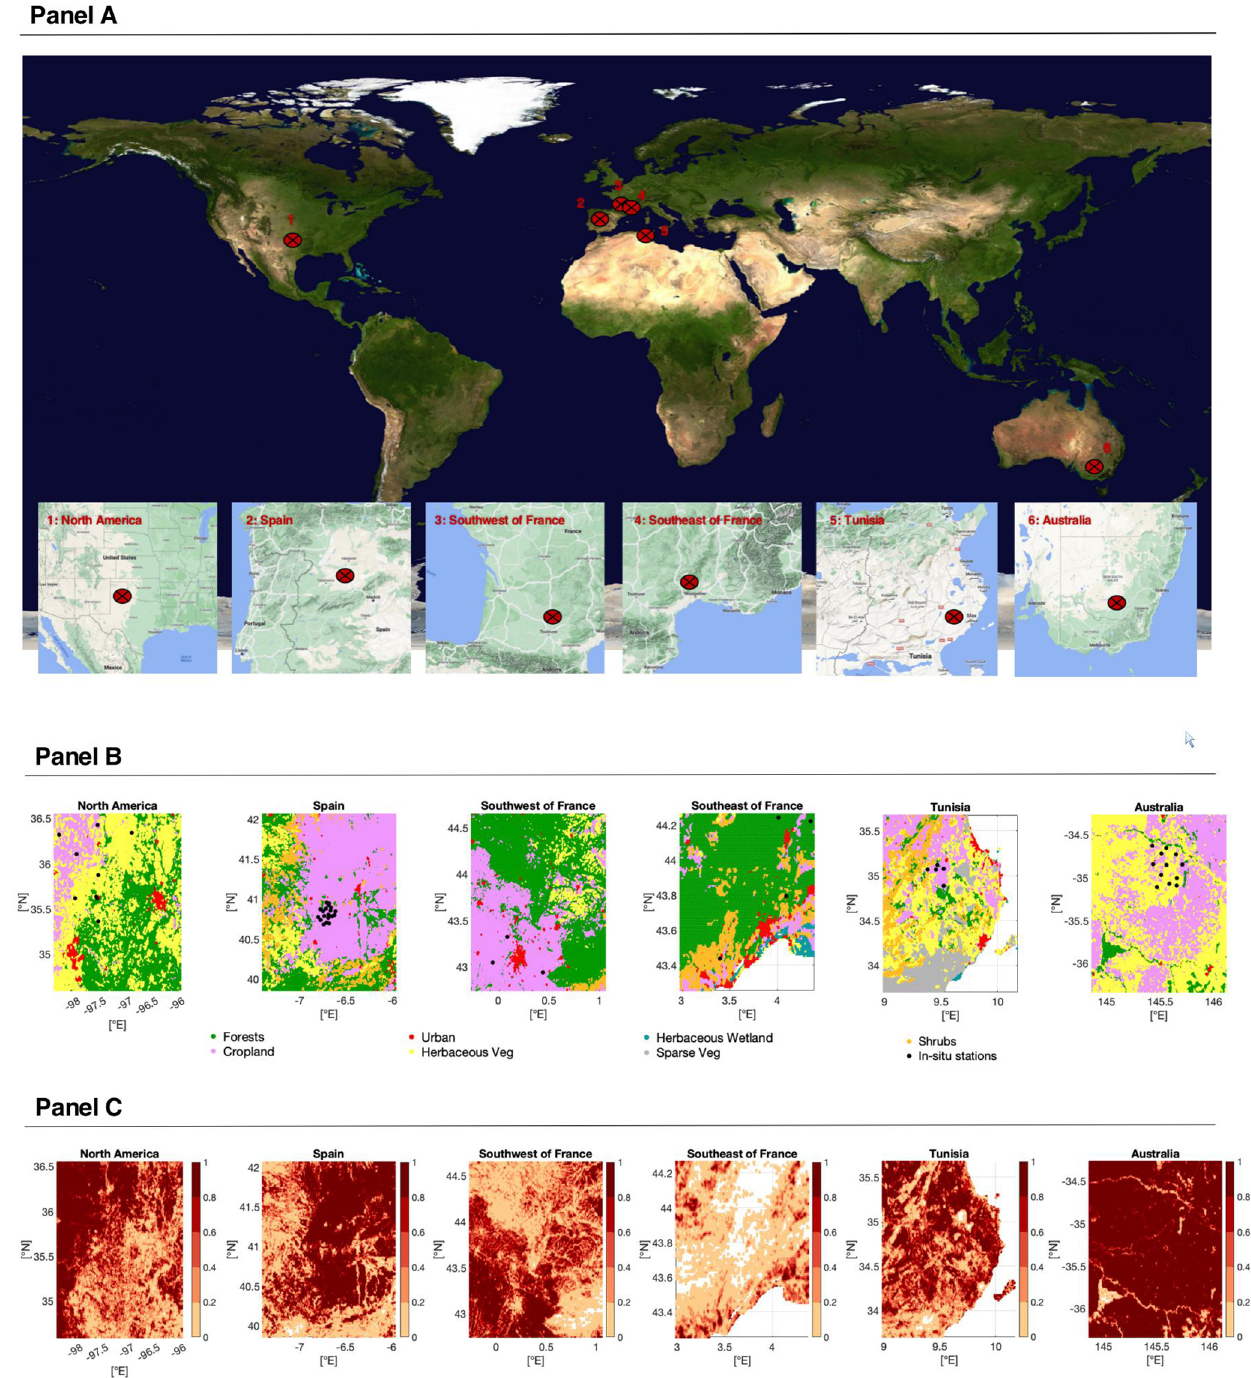
Figure 1. (a) Global locations of the six regions of study (© Google Maps 2022). (b) Copernicus land cover maps of the six regions of study aggregated at 1km spatial resolution. Only the dominant land cover type within a 1km 2 pixel is shown. For instance, a pixel characterized as forests can contain 27% of forests, 26% of croplands, 24% of herbaceous vegetation, and 23% of shrublands or 90% of forests and 10% of herbaceous vegetation. The in situ stations are shown as black dots. One black dot can correspond to several sensors, since some of them have the same coordinates. (c) Proportion of croplands and herbaceous vegetation within each 1km 2 pixel for the six regions of study. The proportion is expressed as a percentage ranging from 0 to 1. Pixels with no cropland or herbaceous vegetation at all are shown as white areas.